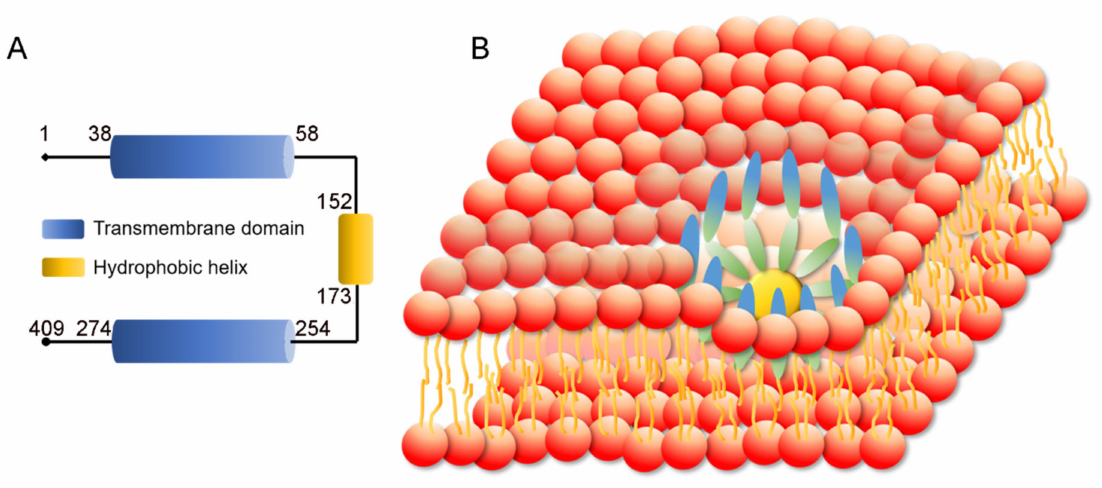
Figure 2. Structure of Berardinelli-Seip congenital lipodystrophy type 2 protein (SEIPIN). ( A ) SEIPIN consists of two transmembrane domains and a hydrophobic helix domain. ( B ) Human SEIPIN is a ring-shaped trans-membrane protein complex, which consists of 11